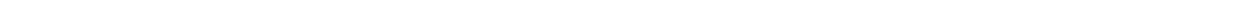
Figure 5 | Asxl2 deletion alters the expression of genes associated with myeloid cells and apoptosis in LK cells. ( a ) The heatmap shows the cluster of 160 DEGs between WTand Asxl2 (cid:2) / (cid:2) LK cells ( P o 0.05, FDR o 0.25 and fold change Z 1.5). Red and blue indicate 68 up- and 92 downregulated genes, respectively. ( b ) Enrichment map is used for visualization of the results of IPA analyses about Diseases and Biological Functions for 565 DEGs ( P o 0.05). The network of enriched functional terms (Nodes, P o 0.01 and | z -score| Z 1.5 in IPA) is shown. Edges indicate gene overlap between the enriched terms; thickness represents statistical significance of term enrichment. Only edges with a Fisher’s exact test nominal P o 10 (cid:2) 4 were visualized. Terms linked by red lines with positive z -scores indicate that functional activity is increased, whereas that by blue ones with negative z -scores mean decreased activity. Oval indicates functional cluster, which includes relevant terms. ( c ) GSEA plots showing dysregulated gene expression of myeloid cell development, haematopoiesis, nucleosome/chromatin assembly, apoptosis and Fas pathway signatures in Asxl2 (cid:2) / (cid:2) LK cells. The normalized enrichment score (NES) and P -value are shown. ( d ) qPCR showing upregulation of Prdm16 and downregulation of Casp3 and Fas in Asxl2 (cid:2) / (cid:2) LK cells compared with WT cells. Data are presented as mean ± s.e.m. Comparisons between two groups were performed by two-tailed unpaired Student’s t- test ** P o 0.01 and *** P o